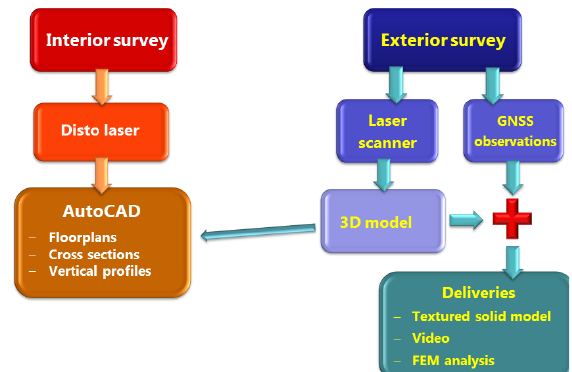
Figure 9: Leica target pole used for traversing with the